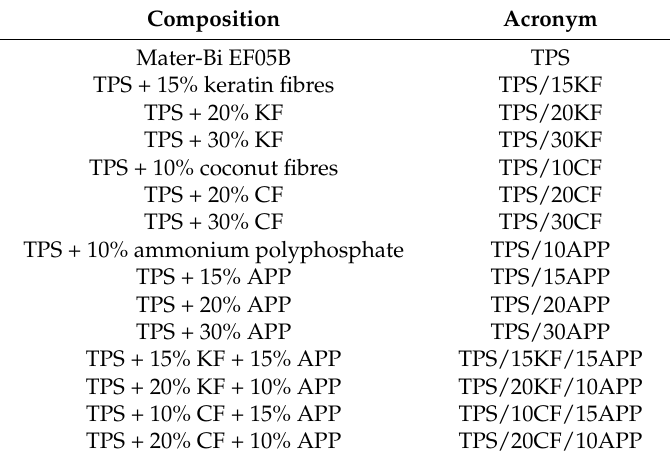
Table 1. Composition of investigated TPS-based